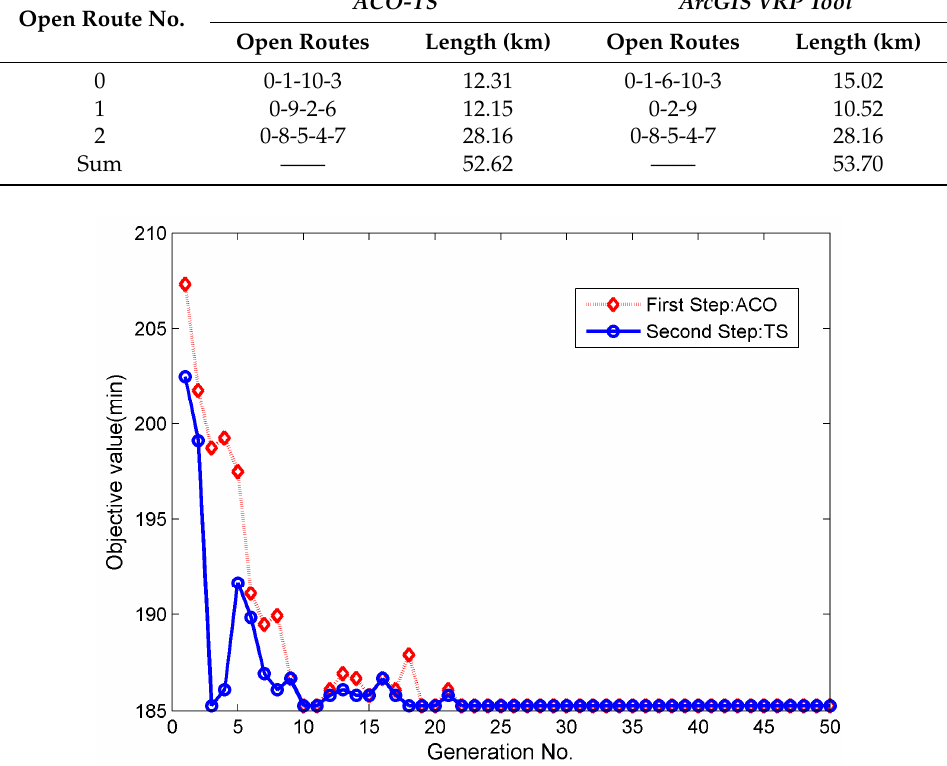
Figure 7. Objective value of R in the optimization process using the ACO-TS.